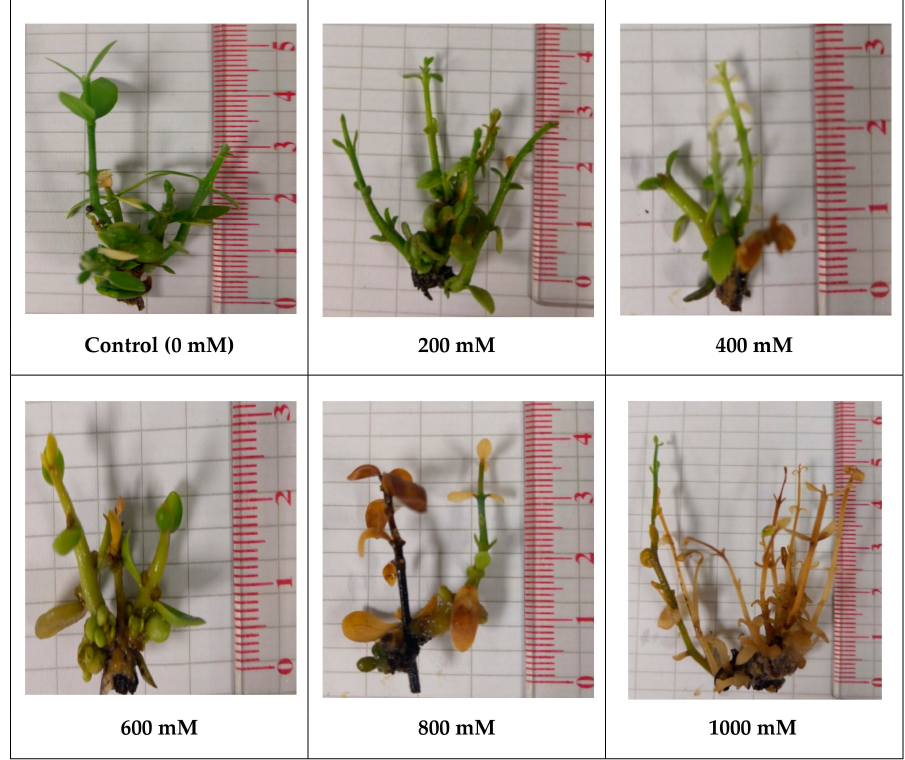
Figure 1. Treated jojoba plants growing on Murashige–Skoog (MS) medium with di ff erent levels of